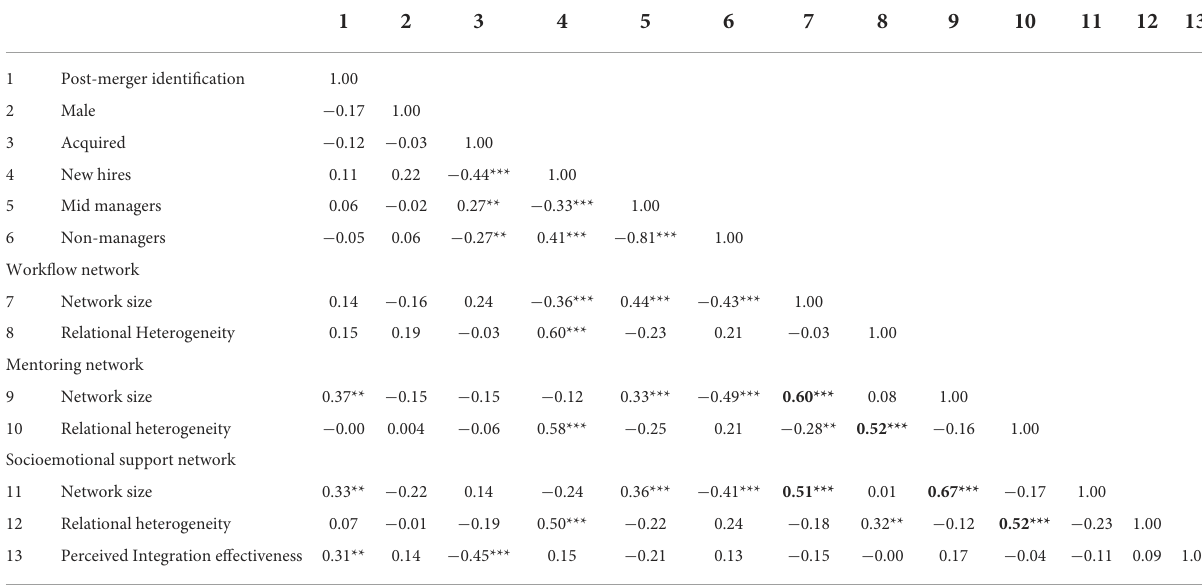
TABLE 2 Correlations of post-merger identification, control, network variables and perceived integration